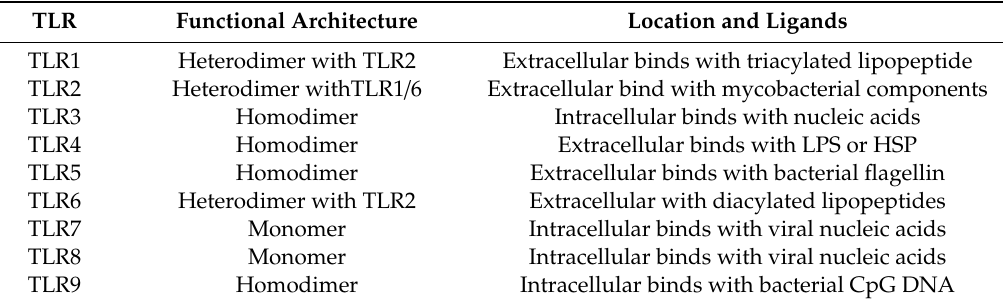
Table 1. Toll-like receptors (TLRs) and their signaling pathways. TLR Functional Architecture Location and Ligands Heterodimer with TLR2 Extracellular binds with triacylated lipopeptide Heterodimer withTLR1 / 6 Extracellular bind with mycobacterial